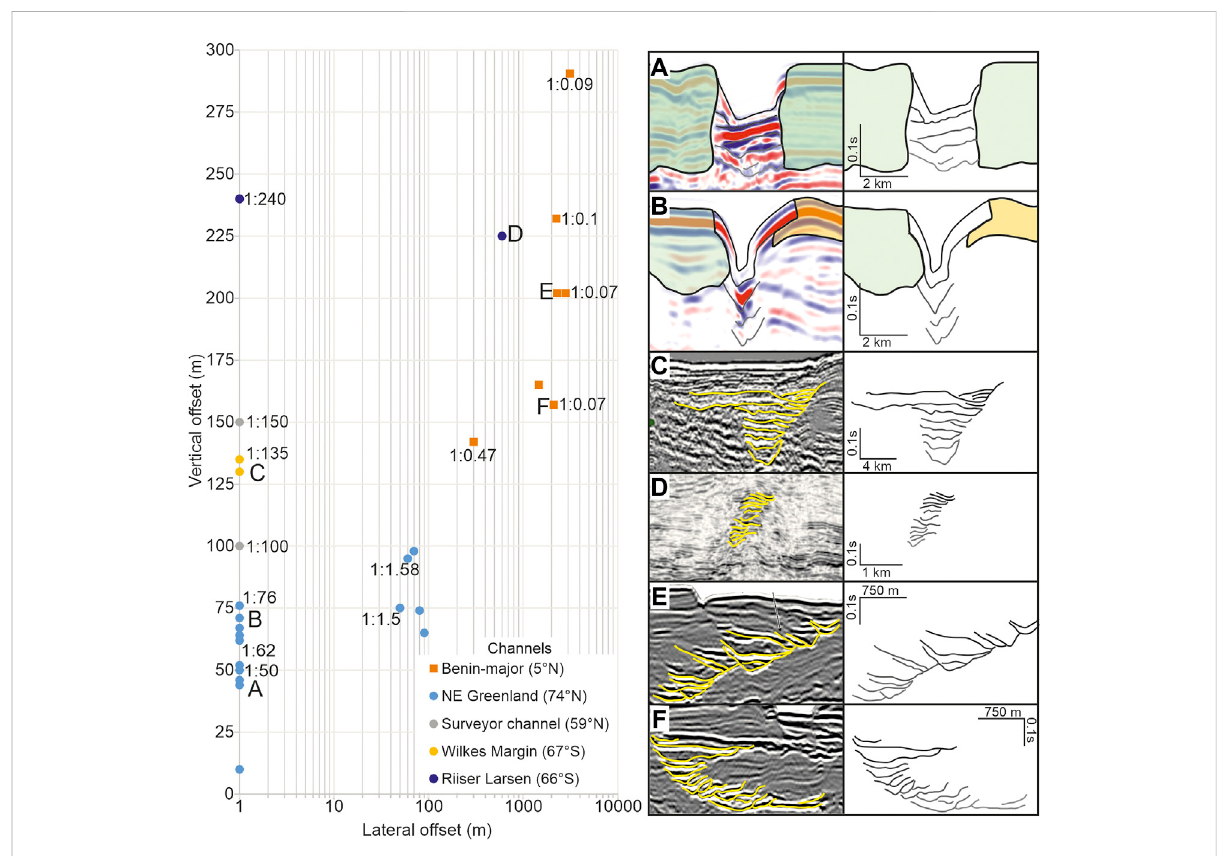
FIGURE 11 Comparison of vertical and lateral offset data plotted for 27 channel sections, with examples from NE Greenland shown in blue, Benin-Major (Deptuck et al., 2003, 2007), the Surveyor channel (Reece et al., 2011), the Wilkes Margin (Passchier et al., 2019) and the Riiser-Larsen Sea (Kuvaas et al., 2004). Examples (A – D) are from high latitude systems showing high vertical aggradation, and examples (E,F) from low latitude systems, showing a variety of lateral offsets. Lateral offset is measured by recording location of left-hand side channel fl oor in the basal cut, and measuring horizontal distance to the same location in the top cut – ratios of some systems are included. It is worth noting that channel systems showing no lateral offset may have offsets under the horizontal resolution of their respective